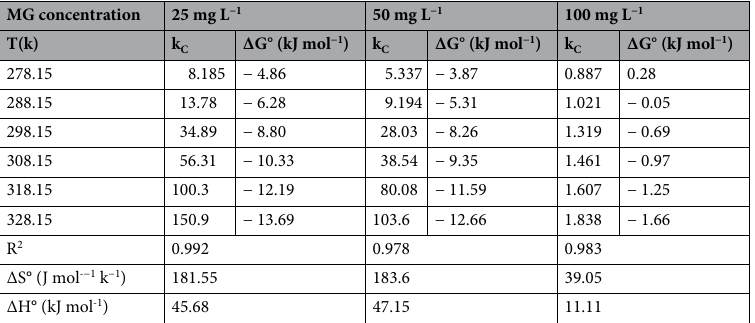
of the MG dye adsorption onto meso-CaAl 2 O 4 at different MG dye concentrations are presented in Table 6. As can be seen, the ∆G° values are in a negative range that implies the spontaneous MG dye adsorption onto meso-CaAl 2 O 471 . Also, the ∆G° values decrease as the temperature rises, meaning that adsorption seems to be more desirable at higher temperatures. The obtained positive quantity of ∆H° (45.68, 47.15, and 11.11 kJ mol –1 ) indicates that the process of MG dye adsorption is done endothermically 72 . In MG concentrations of 25 and 50 mg L −1 , a significant interaction between the MG dye and meso-CaAl 2 O 4 is also concluded by the high value of ∆H° 73 . However, decreasing the ∆H° at higher MG concentrations (100 mg L −1 ) indicates a decrease in the interactions between the meso-CaAl 2 O 4 and the MG dye, which can be due to the quick saturation of active sites on the exterior surface of meso-CaAl 2 O 4 at higher concentrations and prevents the accessing of more dye molecules to more unoccupied active sites. The values of ∆S° (181.55, 183.6, and 39.05 J mol –1 ,) are also positive, which suggests the increment of randomness at the interface of the meso-CaAl 2 O 4 /solution during the process of MG dye adsorption 74 . This degree of randomness has decreased with decreases the mobility of molecules at higher MG concentrations (100 mg L −1 ).